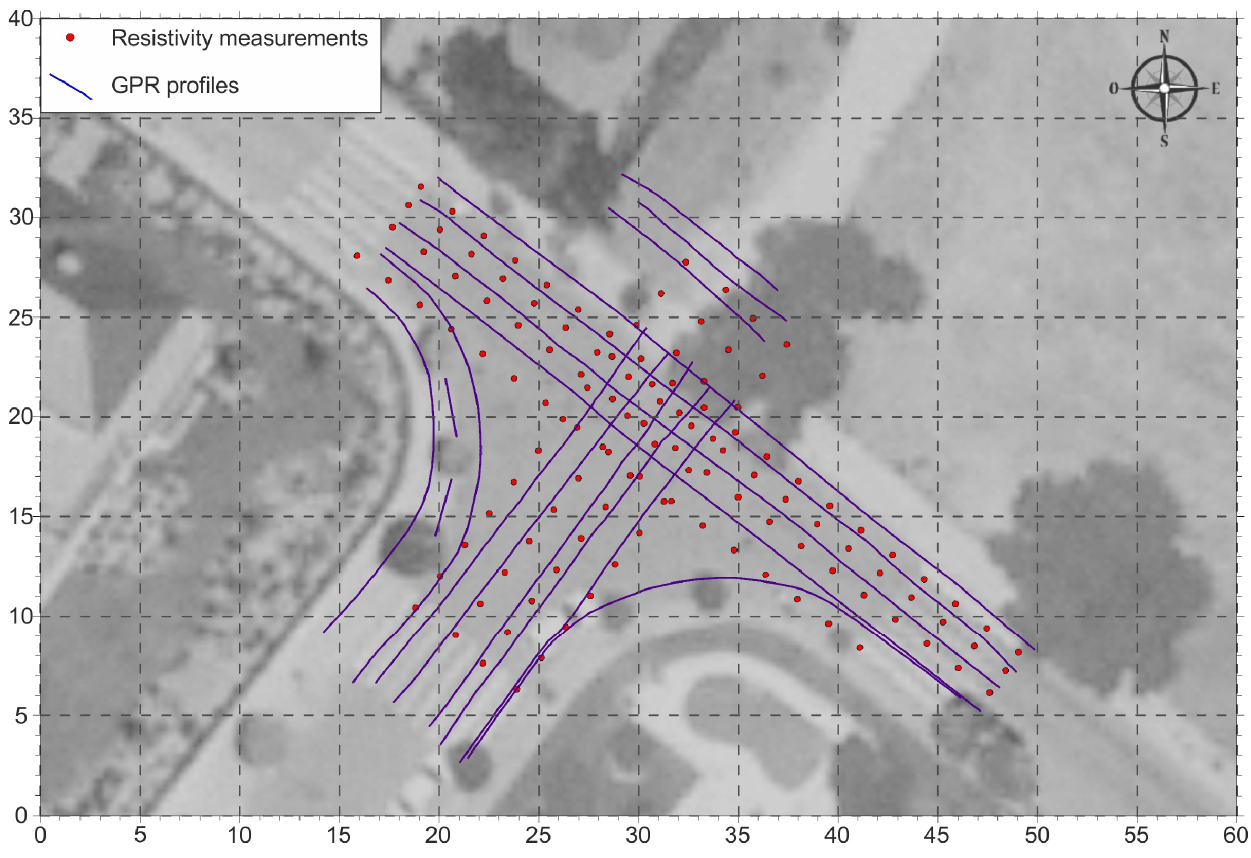
Figure 4. Location of the GPR profiles (blue lines) and resistivity measurements (red dots) of the study area.